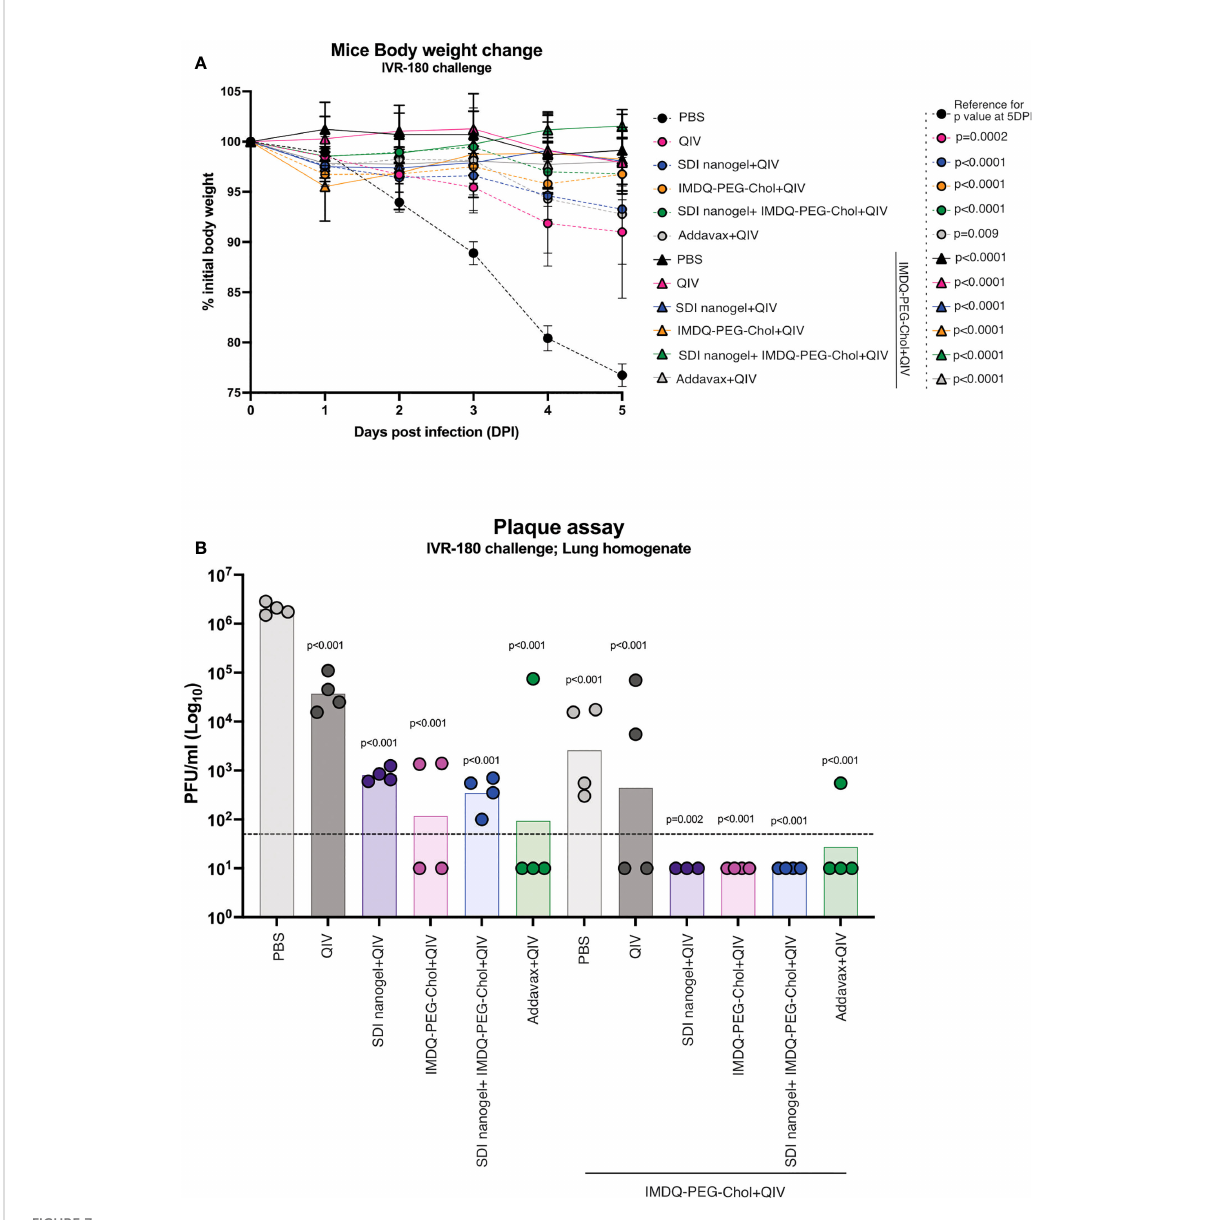
FIGURE 7 QIV combined with SDI+nanogel and/or IMDQ-PEG-Chol protects the animals against a lethal dose of IVR-180 virus: All unvaccinated and QIV ± adjuvant vaccinated animals were intranasally challenged with 100LD 50 (18000 PFU/animal) of IVR-180 virus. (A) The body weights were recorded every day for 5 days post-infection and represented as percentage initial body weight. Day 0 represents the day of infection. (B) The viral lung titers were quanti fi ed by plaque assays on MDCK cells and are represented as Plaque ‐ forming ‐ unit (PFU)/ml for n=4 animals per group (geometric mean with geometric SD). Statistical analysis was performed using two-sided unpaired T test. The p values shown are calculated in reference to the PBS group which received no vaccination in both ( A ; 5 days post infection) and (B)